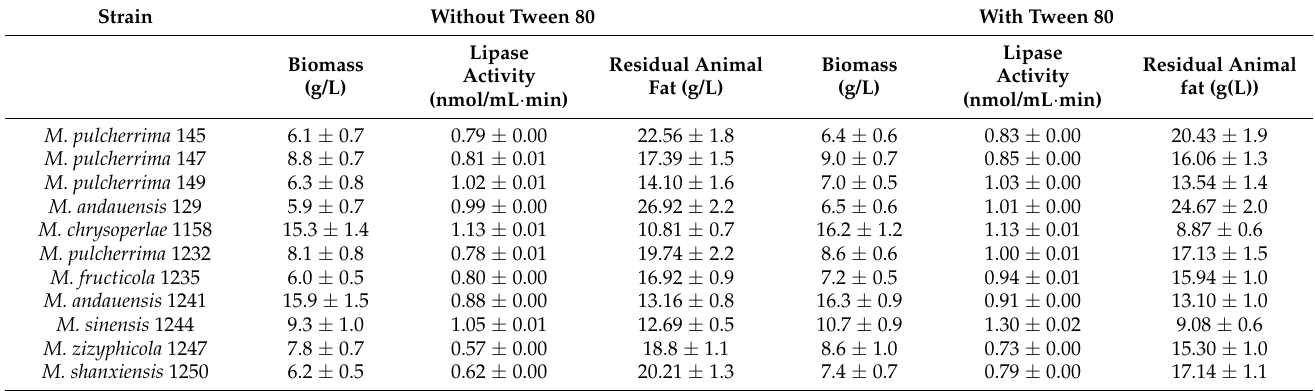
Table 8. Enzymatic activity of lipase (nmol/mL.min) on crude animal fat medium (47 g/L) and medium with addition of Tween 80 medium with added Tween 80 emulsifier and amount of residual fat (from supernatant) after 14 days of cultivation on low